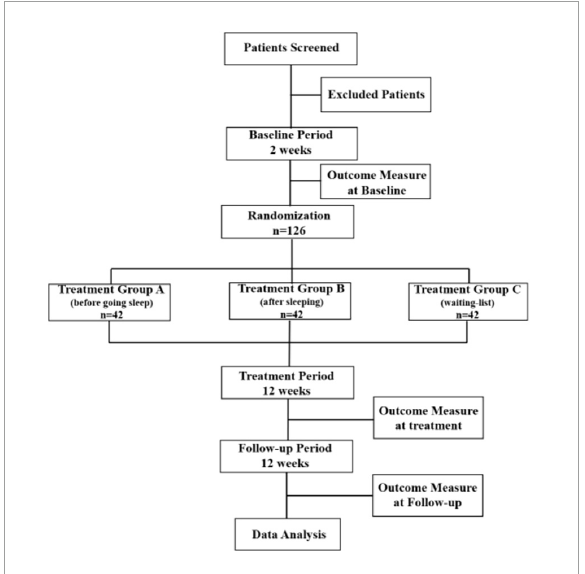
FIGURE1 Flowchart of the study